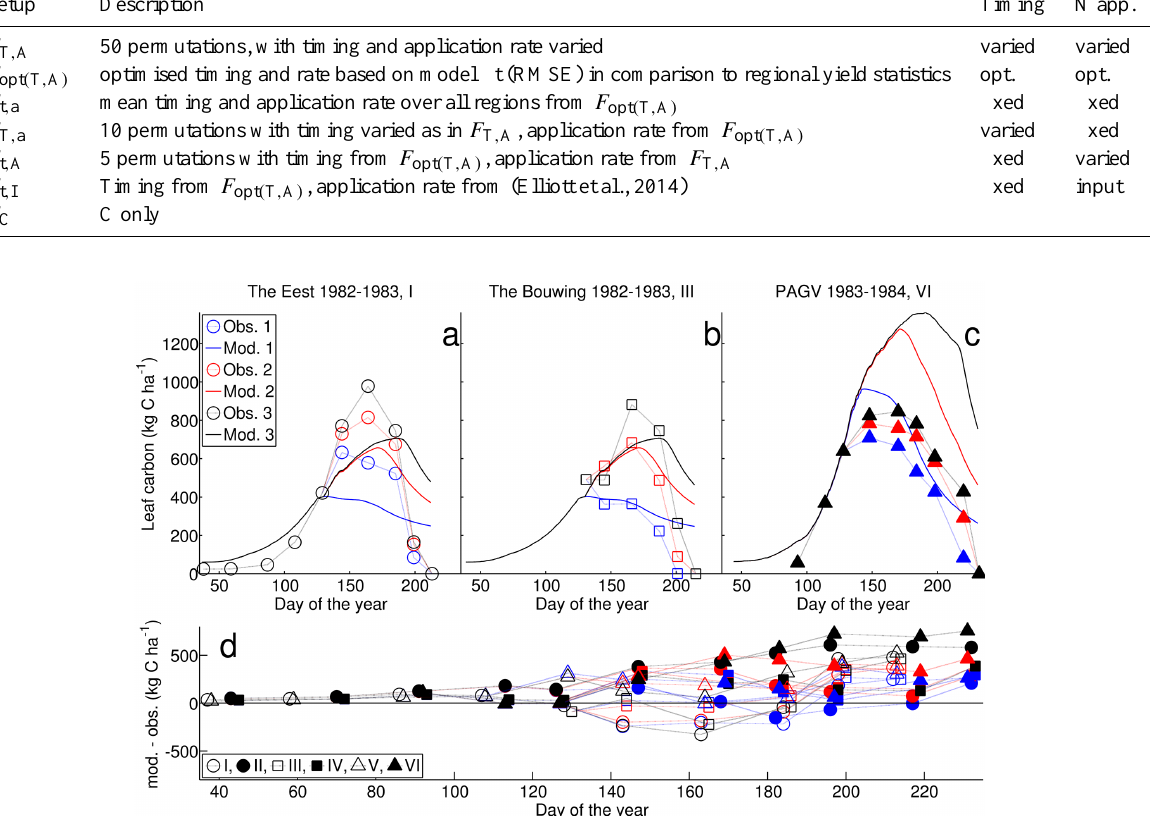
Table 3. Description of the setups used in the comparison with regional statistics, with abbreviations used throughout the paper. Setup Description Timing N app. F T , A 50 permutations, with timing and application rate varied varied varied F opt ( T , A ) optimised timing and rate based on model fit (RMSE) in comparison to regional yield statistics opt. opt. F t , a mean timing and application rate over all regions from F opt ( T , A ) fixed fixed F T , a 10 permutations with timing varied as in F T , A , application rate from F opt ( T , A ) varied fixed F t , A 5 permutations with timing from F opt ( T , A ) , application rate from F T , A fixed varied fixed input